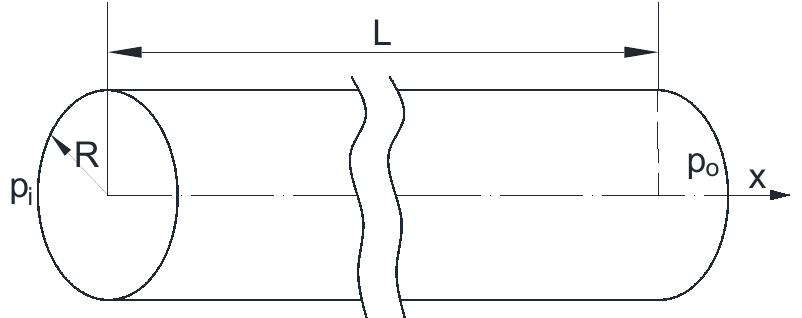
Figure 1. Layout of the pipe considered in the present review.